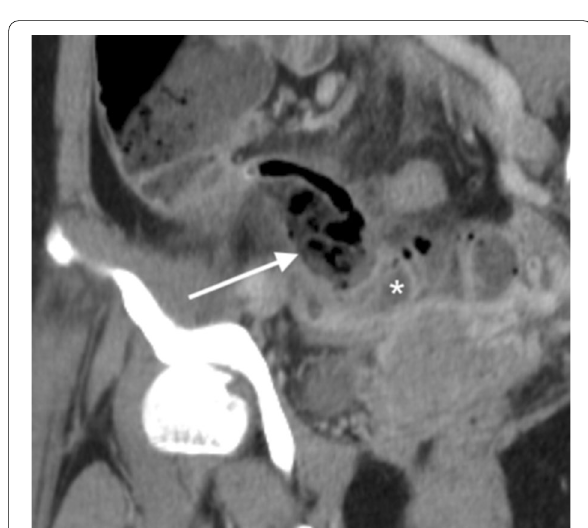
Fig. 8 Fluid and air collection. A coronal-reformatted CT image of a 54-year-old woman presenting with right lower abdominal pain and fever for 20 h, elevated white blood cell counts (18,060 cells/ mm 3 ) and neutrophilia (92.2% neutrophils) shows an extraluminal air bubbles mixed with fluid and enteric content (arrows) inferior to an inflamed appendix. Note moderate-to-severe periappendiceal fat stranding with nearby fluid-filled nondilated small bowel loops. Perforated appendicitis was confirmed at surgery and